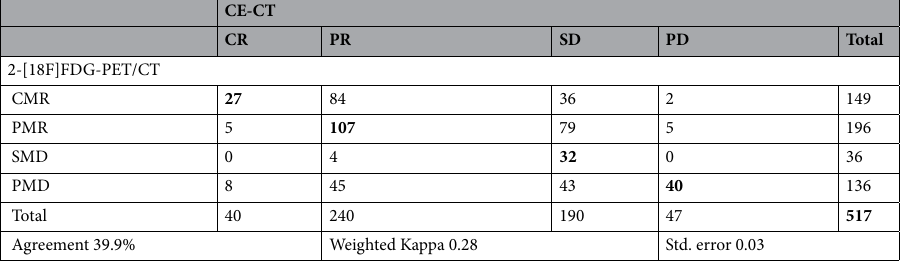
Table 2. Distribution and agreement between response categorization according to CE-CT and 2-[ 18 F]FDG- PET/CT in 87 patients with 517 follow-up scans. Significant values are in [bold]. C(M)R complete (metabolic) response, P(M)R partial (metabolic) response, S(M)D stable (metabolic) disease, P(M)D progressive (metabolic) disease.